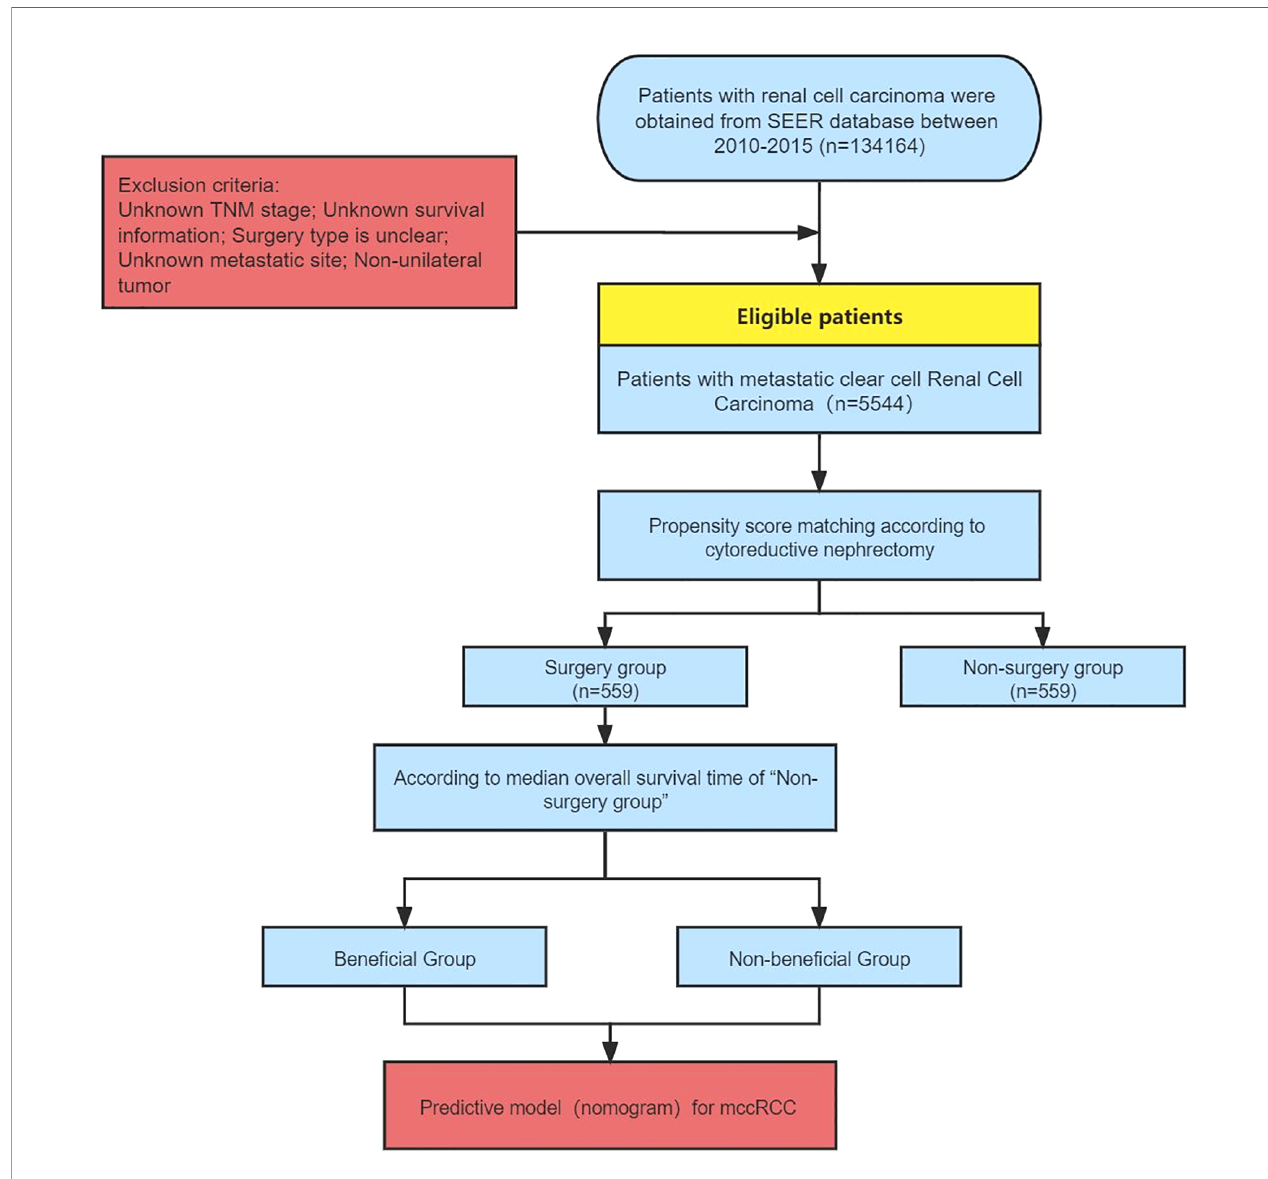
FIGURE 1 | Flowchart of patient selection and establishment of the predictive